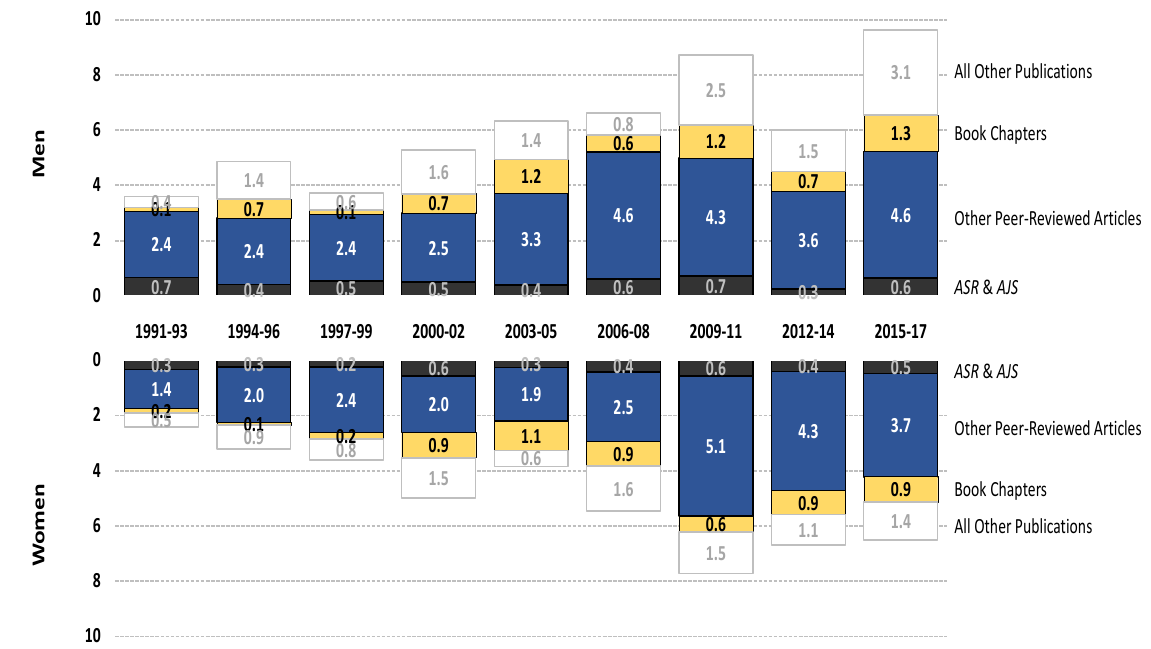
Figure 13: Mean number of publications for new assistant professors by type, year, and